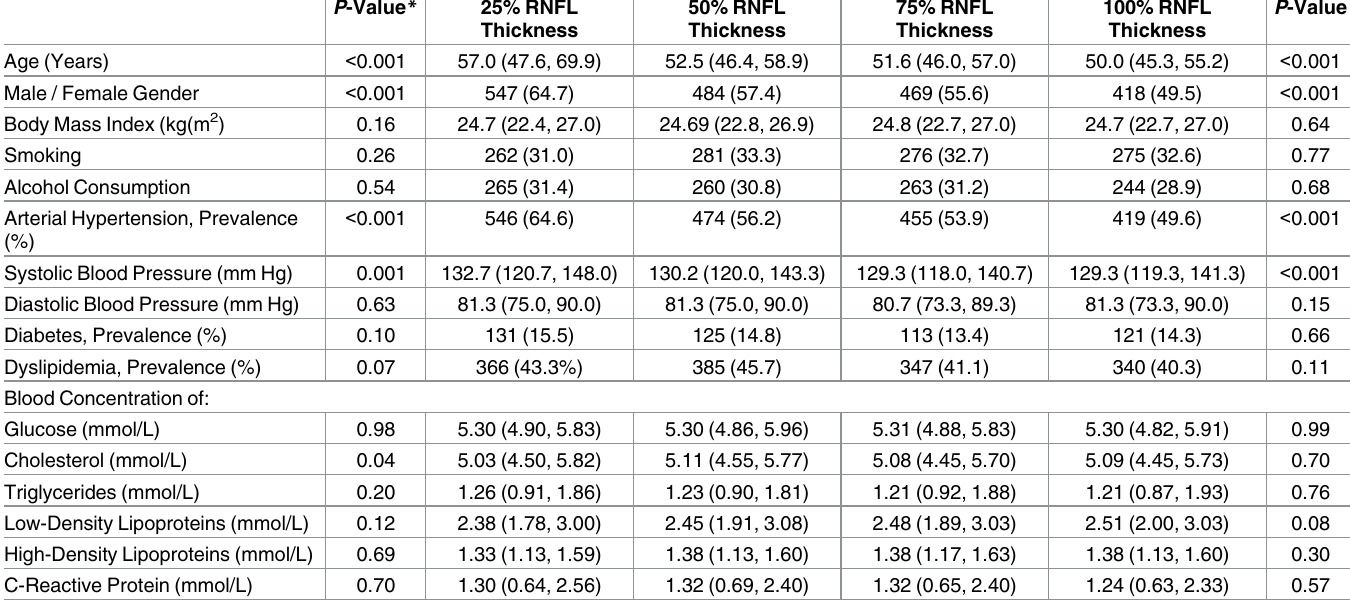
Table 1. Univariate analysis of associations between retinal nerve fiber layer (RNFL) thickness and other variables, and baseline characteristics of individuals in the asymptomatic polyvascular abnormalities in community study, stratified into quartile groups of RNFL thickness.